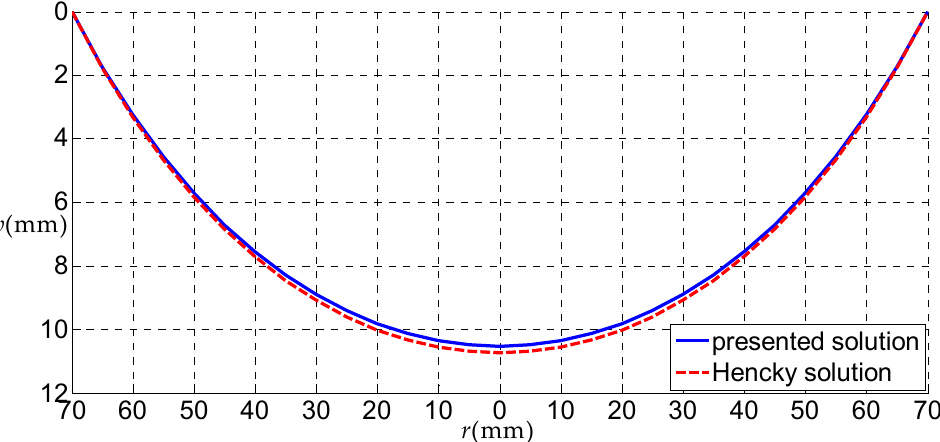
Figure 6. The variations of w with r when q = 0.01 MPa.